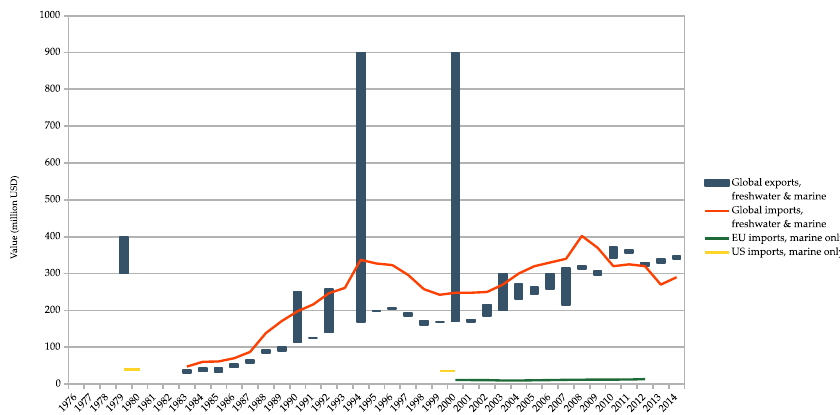
Figure 3. Comparison of export (minimum and maximum) and import value in million USD of the freshwater and marine ornamental fish trade, without accessories, from 1976 to 2014 [4,7,12,15–17,29, 33,34,39–54]. For marine ornamental fishes, the global import value in 1979 and 2001 (yellow) [1,37] and for the EU between 2000–2011 (green) [38] is